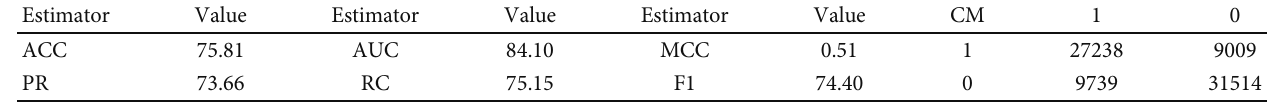
Table 1: Evaluation metrics for the model of chronic complications in patients with diabetes.